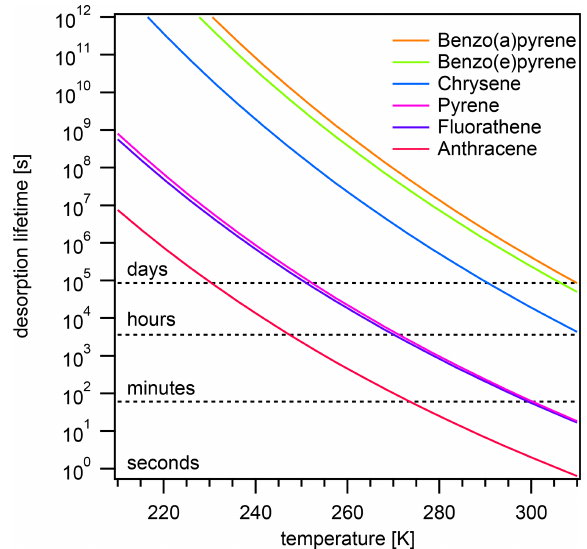
Figure A3. Desorption lifetime ( τ des = 1 /k des ) of selected PAHs as a function of temperature.